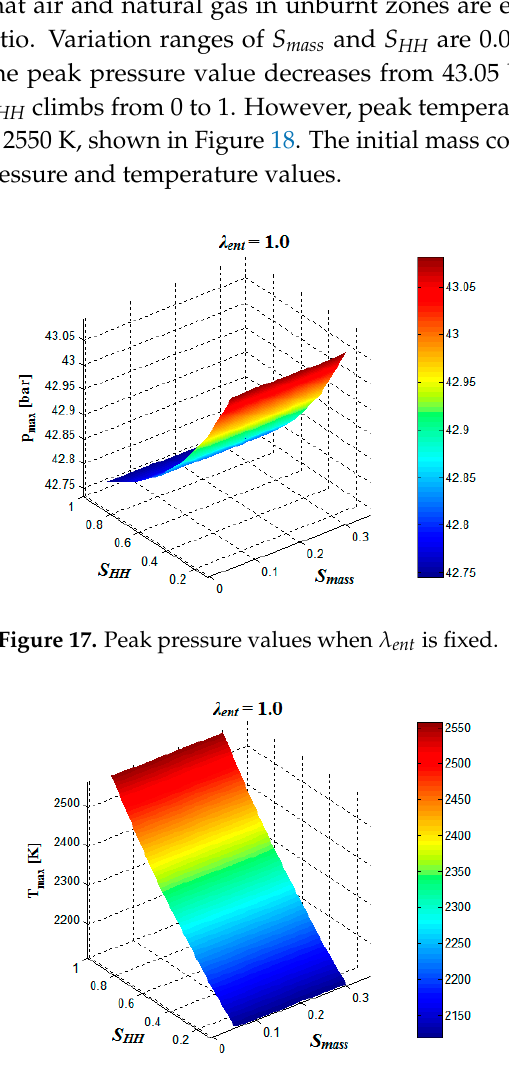
Figure 18. Peak temperature values when λ ent is fixed.